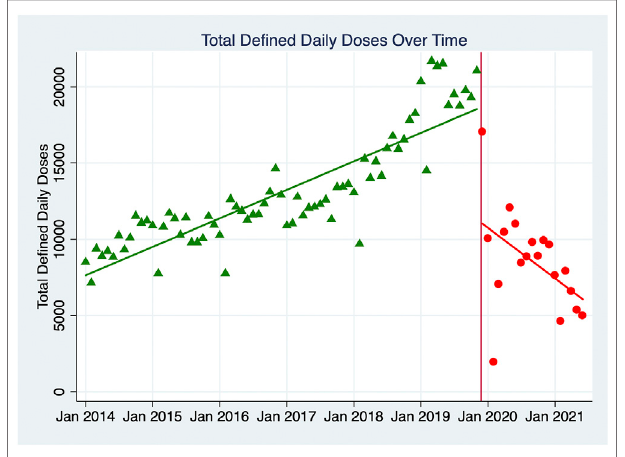
FIGURE 1 | Monthly total De fi ned Daily Doses of ten NKMDs combined. The monthly DDDs for all NKMDs combined over time was demonstrated, from January 2014 to June 2021. The linear trends of DDDs in the pre- intervention period and the post-intervention period were labeled with different colors, green-pre-intervention period and red-the post-intervention period.